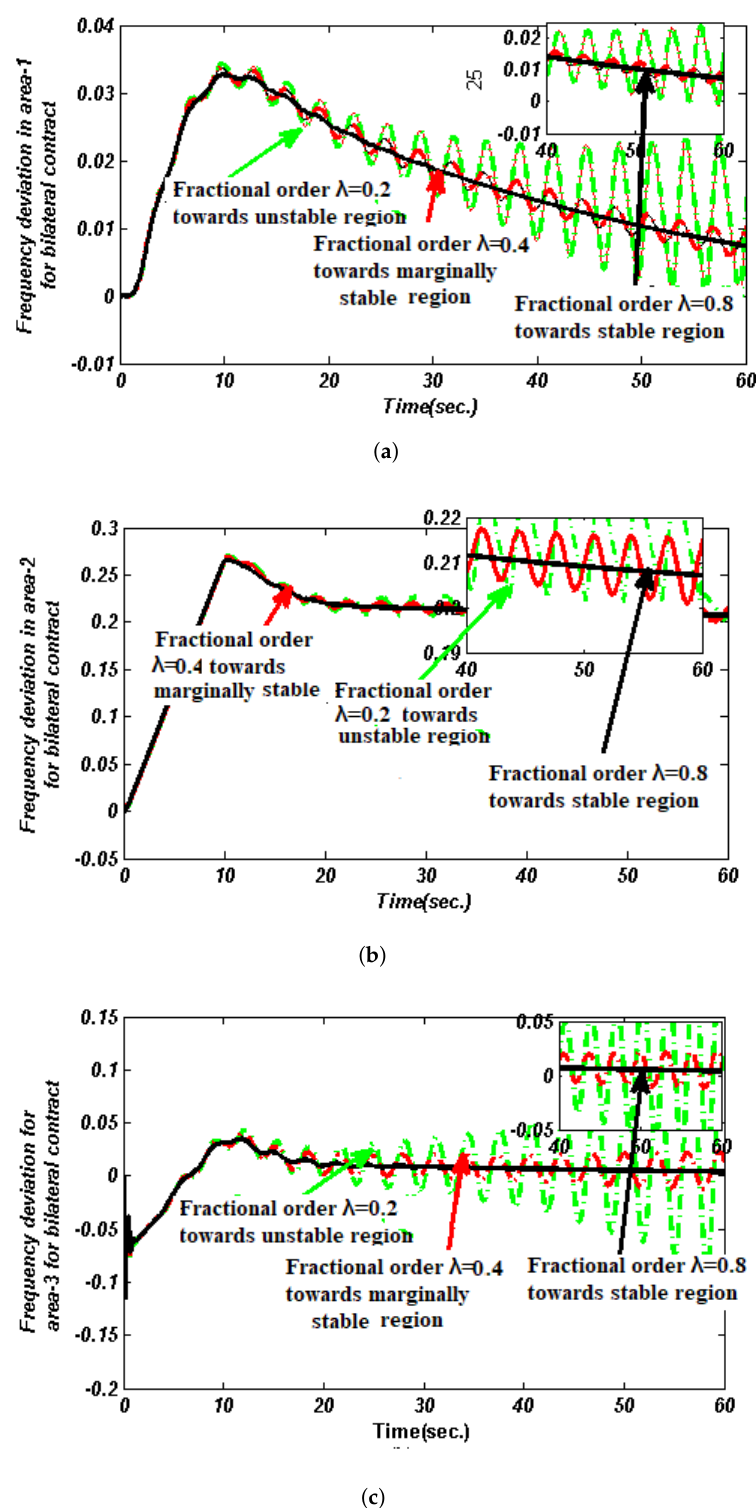
Figure 7. ( a ) Area 1 frequency deviation for Bilateral condition with a 10 % SLP type of load with time-varying delay τ d = 4.325 s. at a rate µ = 0.0. ( b ) Area 2 frequency deviation for bilateral scenario 10% SLP type of load with constant time delay τ d = 3.014 s at a rate of µ = 0. ( c ) Area 3 frequency deviation for 10 % SLP type of load with constant time delay τ d = 3.014 s at rate of µ =